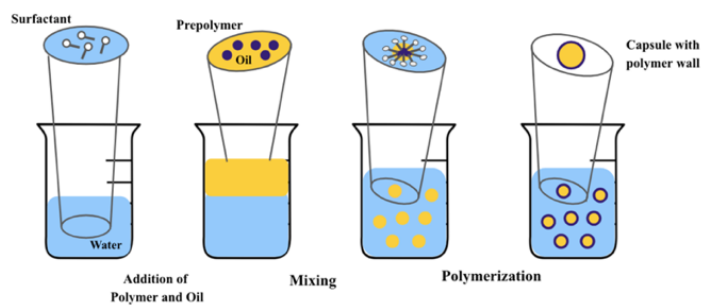
Figure 8. Interfacial polymerization—It occurs between the two immiscible phase interfaces, and results in formation of a polymer strained to the interface. An interfacial polymer is developed at the protein expression site following the polymer straining with a suitable dye. The figure shows formation of a prepolymer upon the addition of polymer and oil, and further mixing and polymerisation leads to the formation of a capsule with polymer wall.